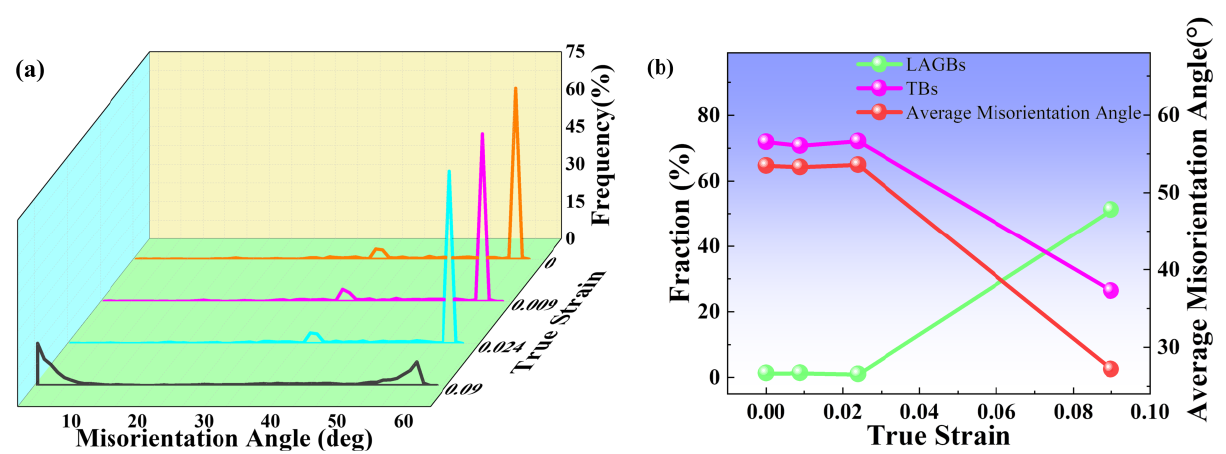
Figure 5. ( a ) Misorientation angle distribution of Cr20Ni80 alloy at various true strains. ( b ) The evolution of various grain boundaries at different true